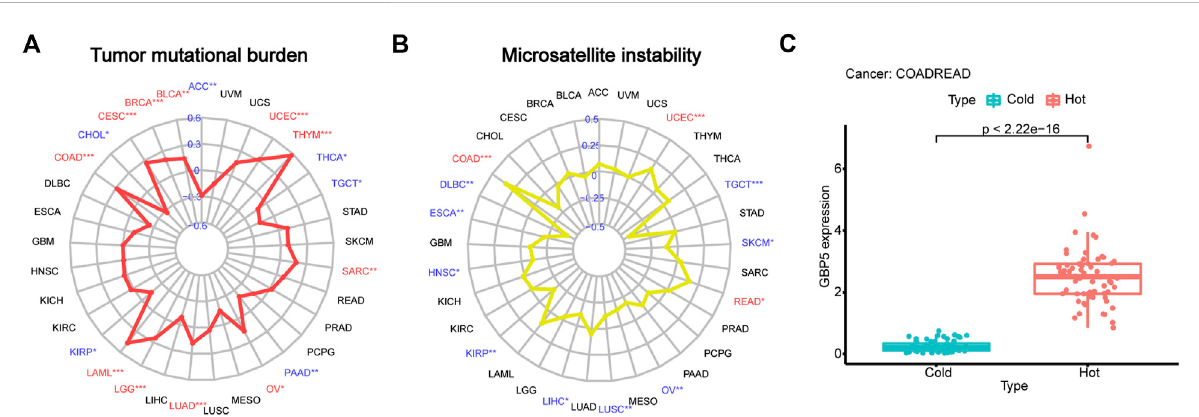
FIGURE 5 Explanation of GBP5 immunogenicity (A) Correlation between GBP5 and TMB (tumor mutation burden) in pan-cancer. Respectively, the correlation number and p -value are 0.15 and 0.0024 in BLCA (Bladder urothelial carcinoma), 0.2 and 5.3e-10 in BRCA (Breast invasive carcinoma), 0.27 and 5.2e-06 in CESC (Cervical squamous cell carcinoma and endocervical adenocarcinoma), 0.28 and 8.3e-09 in COAD, 0.46 and 0.00012 in LAML (Acute myeloid leukemia), 0.24 and 3.7e-08 in LGG (Brain lower grade glioma), 0.18 and 4.9e-05 in LUAD (Lung adenocarcinoma), 0.16and0.01inOV(Ovarian serouscystadenocarcinoma),0.18and0.0045inSARC(Sarcoma),0.57and1.3e-11inTHYM(Thymoma),0.32and1.2e- 13 in UCEC (Uterine corpus endometrial carcinoma) (B) Correlation between GBP5 and MSI (microsatellite instability) in pan-cancer. Respectively, the correlation number and p -value are 0.34 and 5.3e-13 in COAD, 0.16 and 0.049 in READ, 0.17 and 0.00011 in UCEC. (C) Differences of GBP5 expression between hot and cold tumors in CRC. The Wilcoxon test is used for the signi fi cance test. “ * ” indicates p < 0.05, “ ** ” indicates p < 0.01 and “ *** ” indicates p <